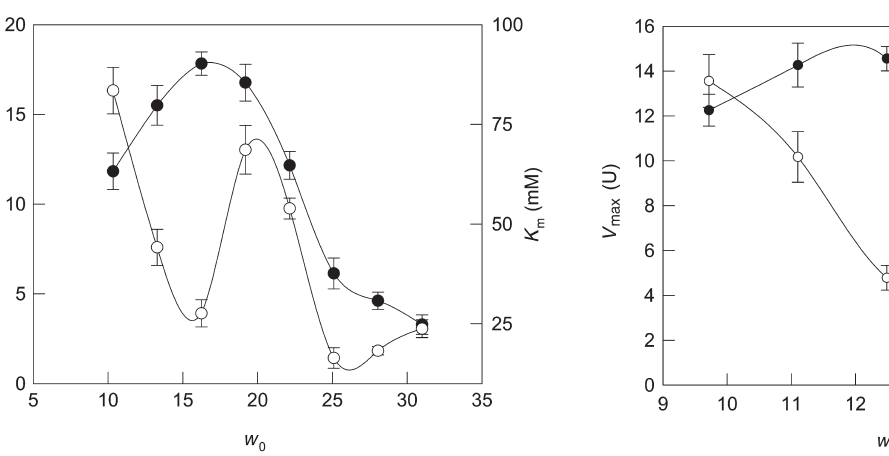
Figure 3. Effect of micellarwater content( w 0 = [H 2 O]/[surfactant])on the kinetic parameters of p NPPase from H. salinarum in reverse mi- celles (0.2 M CTAB and 1 M 1-butanol in cyclohexane): V max ( (cid:5) ) and K m ( (cid:4) ). The reaction was initiated by mixing reverse micelles con- taining p NPPase with reverse micelles containing substrate ( p NPP). The buffer in the water pool was 100 mM Tris-HCl, pH 8.5, contain- ing 100 mM NaCl, 20 mM 2-mercaptoethanol and 5 mM MnCl 2 . Temperature of the reaction was 40 °C. Enzyme concentration was 0.6 µg ml –1 .